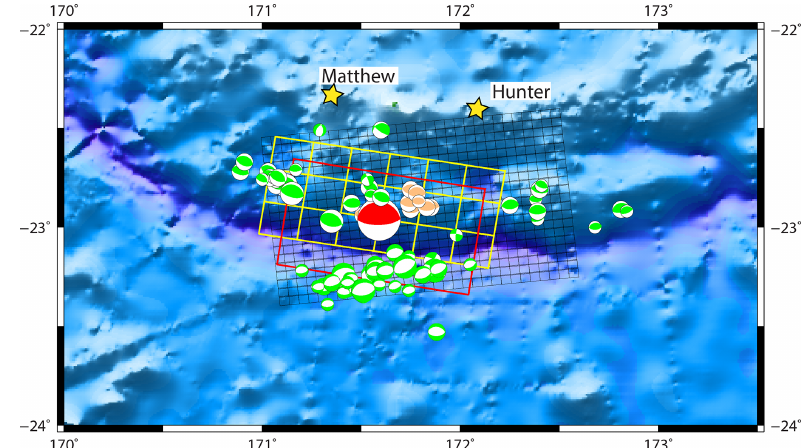
Figure 3. Map of the centroid moment tensors (GCMT project; last accessed on 10 May 2022) calculated for the main earthquakes ( M w ≥ 5) occurring during the February 2021 seismic crisis (from 1 to 28 February) south of Matthew and Hunter islands (yellow stars). Red colour stands for the main shock, orange for the foreshocks, and green for the aftershocks. The extent and the number of subfaults of the three scenarios used in this study is represented by the black, yellow, and red rectangles standing respectively for the USGS finite fault model, the non-uniform model obtained from tsunami waveforms inversion, and the uniform slip